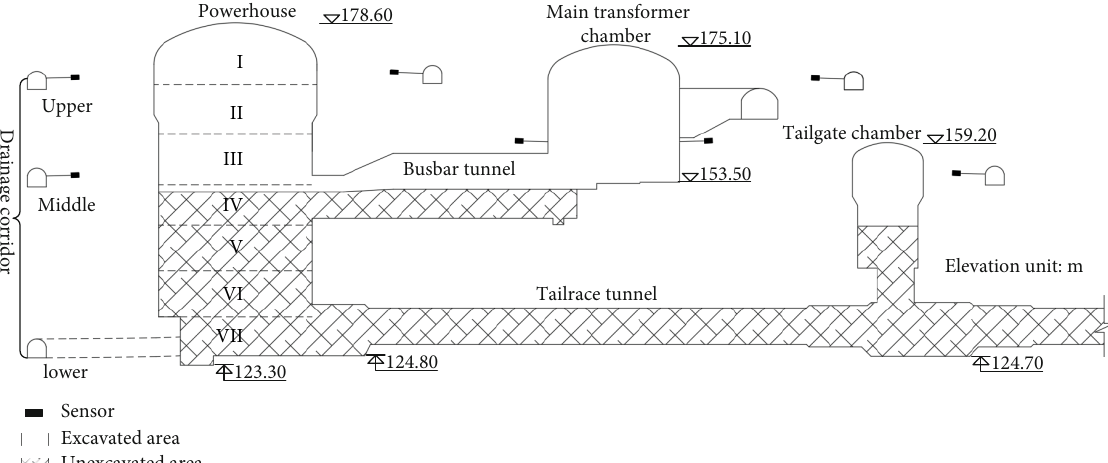
Figure 5: Schematic diagram of layered excavation of underground powerhouse and sensor positions.